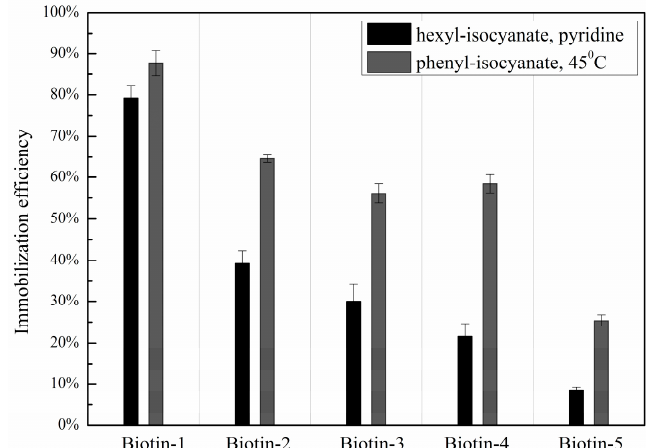
Figure 7. Immobilization efficiencies of five biotinylated compounds with different nucleophilic residues printed on a hexyl-isocyanate functionalized slide followed by catalyzation in pyridine vapor at room temperature vs. those printed on phenyl-isocyanate functionalized slide followed by thermal annealing at 45 °C for 24 h.